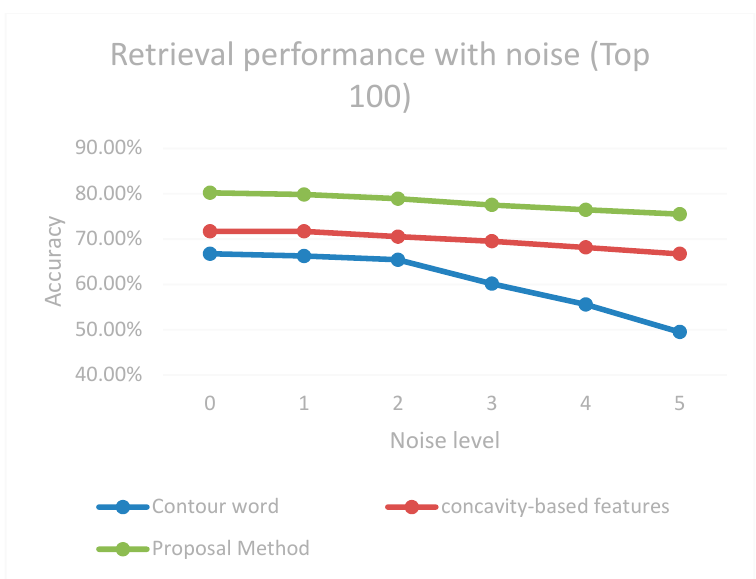
Figure 31. The retrieval performance of two methods with different levels of noise.